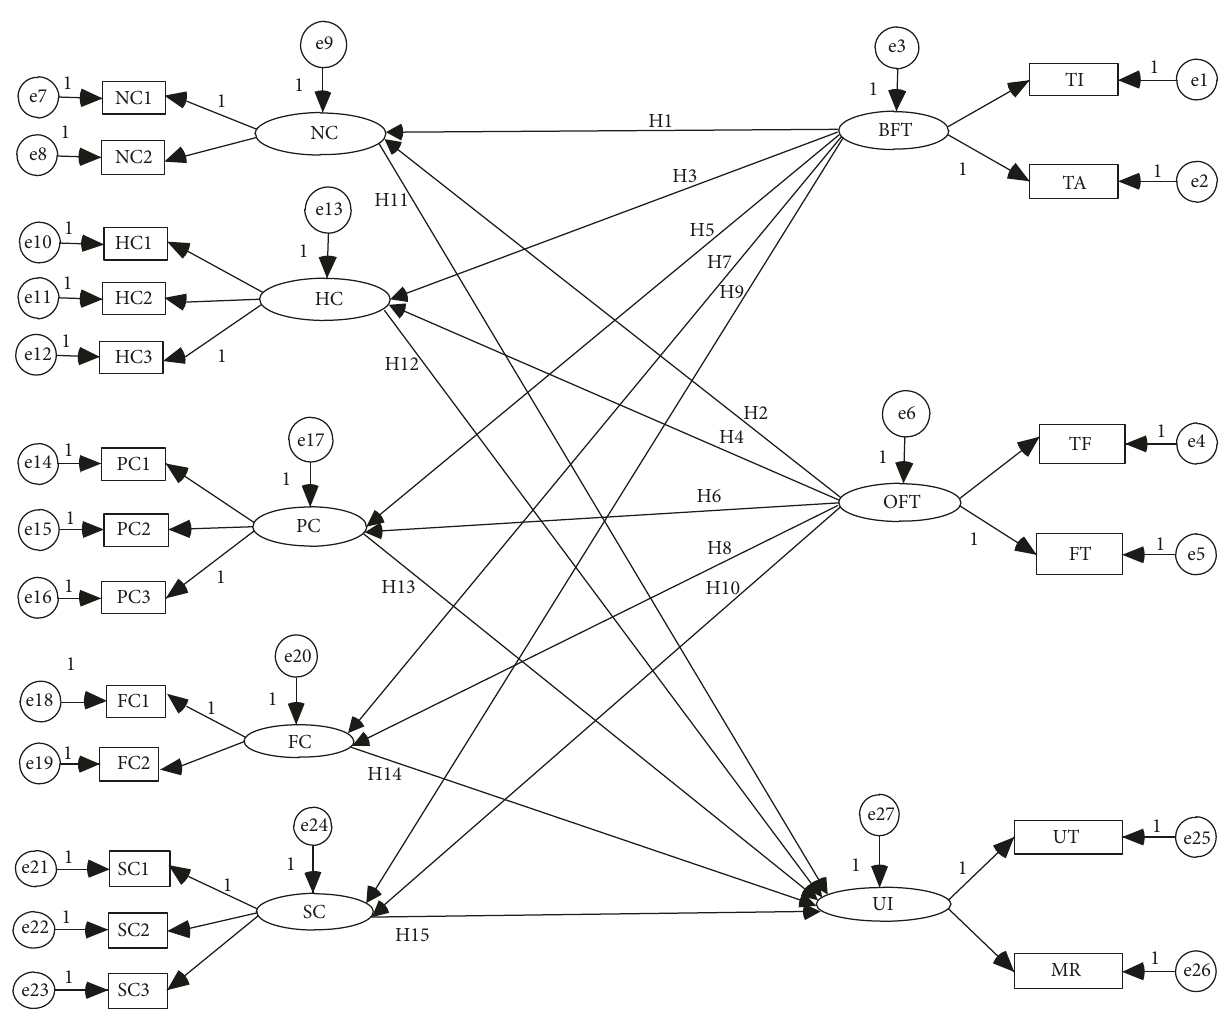
Figure 2: Hypothesized structural equation model . Abbreviations: BFT, Benefit of farmland transfer; OFT, Openness in farmland transfer; TI, Transfer income; TA, Transfer area; TF, Transferee; FT, Farmland transfer tenure; UI, Willingness to urbanism; UT, Urbanization type; MR, Migration region; NC, Natural capital; NC1, Farmland area; NC2, High quality farmland; HC, Human capital; HC1, Education level; HC2, Labour force; HC3, Health status; PC, Physical capital; PC1, Residential quantity; PC2, Residential quality; PC3, Public transportation; FC, Financial capital; FC1, Nonagricultural income; FC2, Capacity to borrow; SC, Social capital; SC1, Relationship with friends; SC2, Relationship with relatives; SC3, Relationship with village